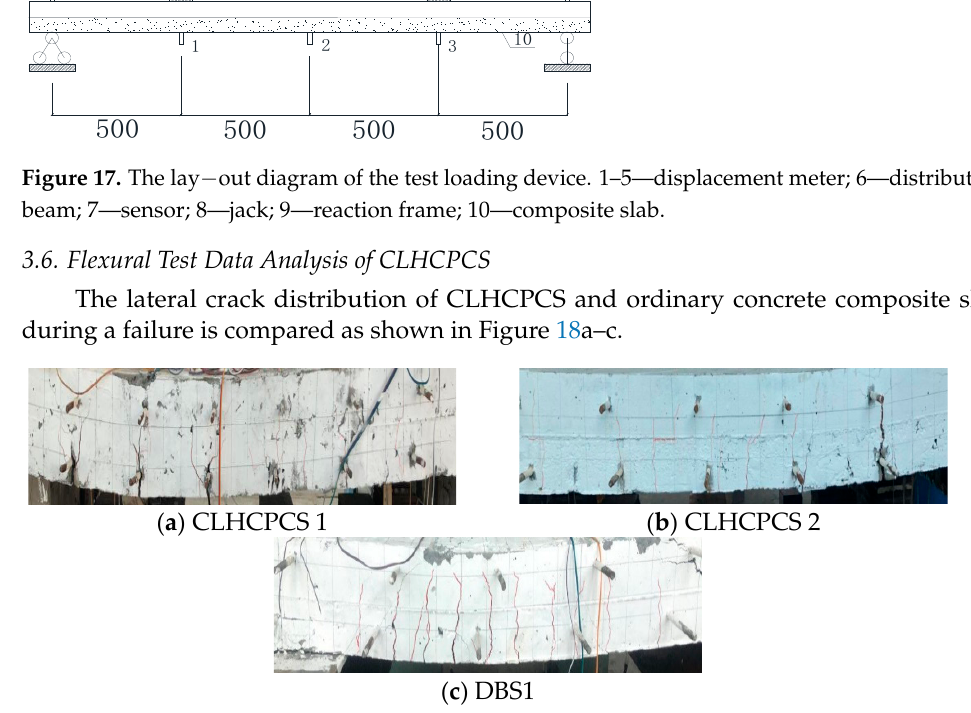
Figure 18. Comparison of crack distribution when CLHCPCS and ordinary concrete composite slab fail.